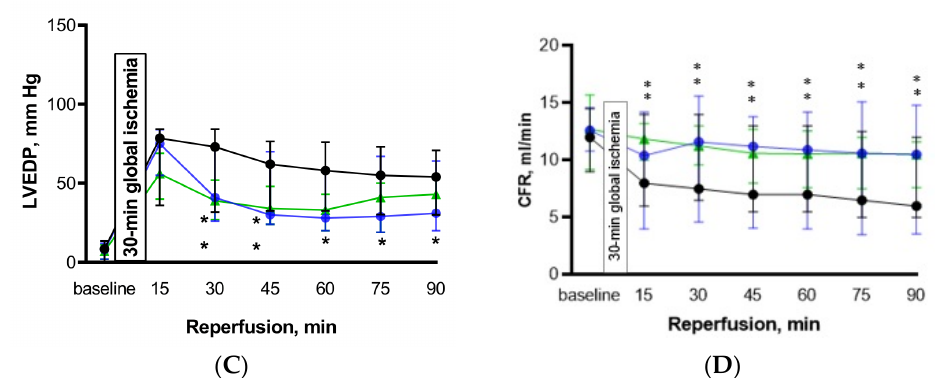
Figure 2. Functional parameters in isolated rat hearts were subjected to 30 min of global ischemia followed by 90 min of reperfusion. Notes: ( A ) Ischemic contracture (LV pressure —left ventricular pressure), ( B ) LVDP—left ventricular developed pressure, ( C ) LVEDP—left ventricular end-diastolic pressure, ( D ) CFR—coronary flow rate at baseline and during the experiment. Notes: Results are presented as median (25%; 75%). CRL—control group, IGT—impaired glucose tolerance group, IGT MET—impaired glucose tolerance + metformin group. * p < 0.05, both groups (IGT and IGT MET groups) in comparison with CRL both groups are separately marked (* < 0.05).